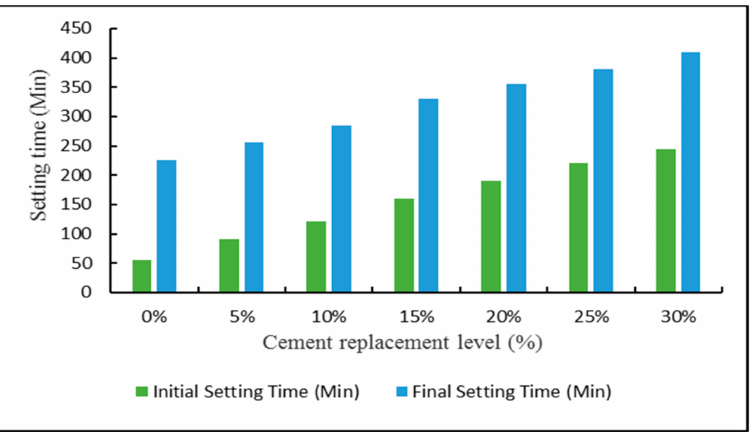
Figure 10. Initial and final setting time of cement paste with